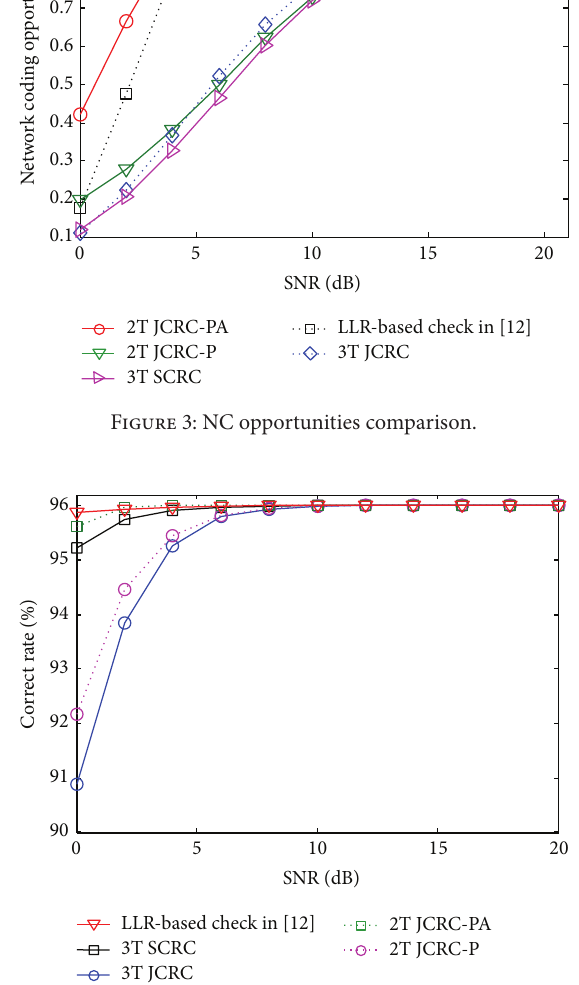
Figure 4: Correct rate comparison of the signals that have success- fully passed the